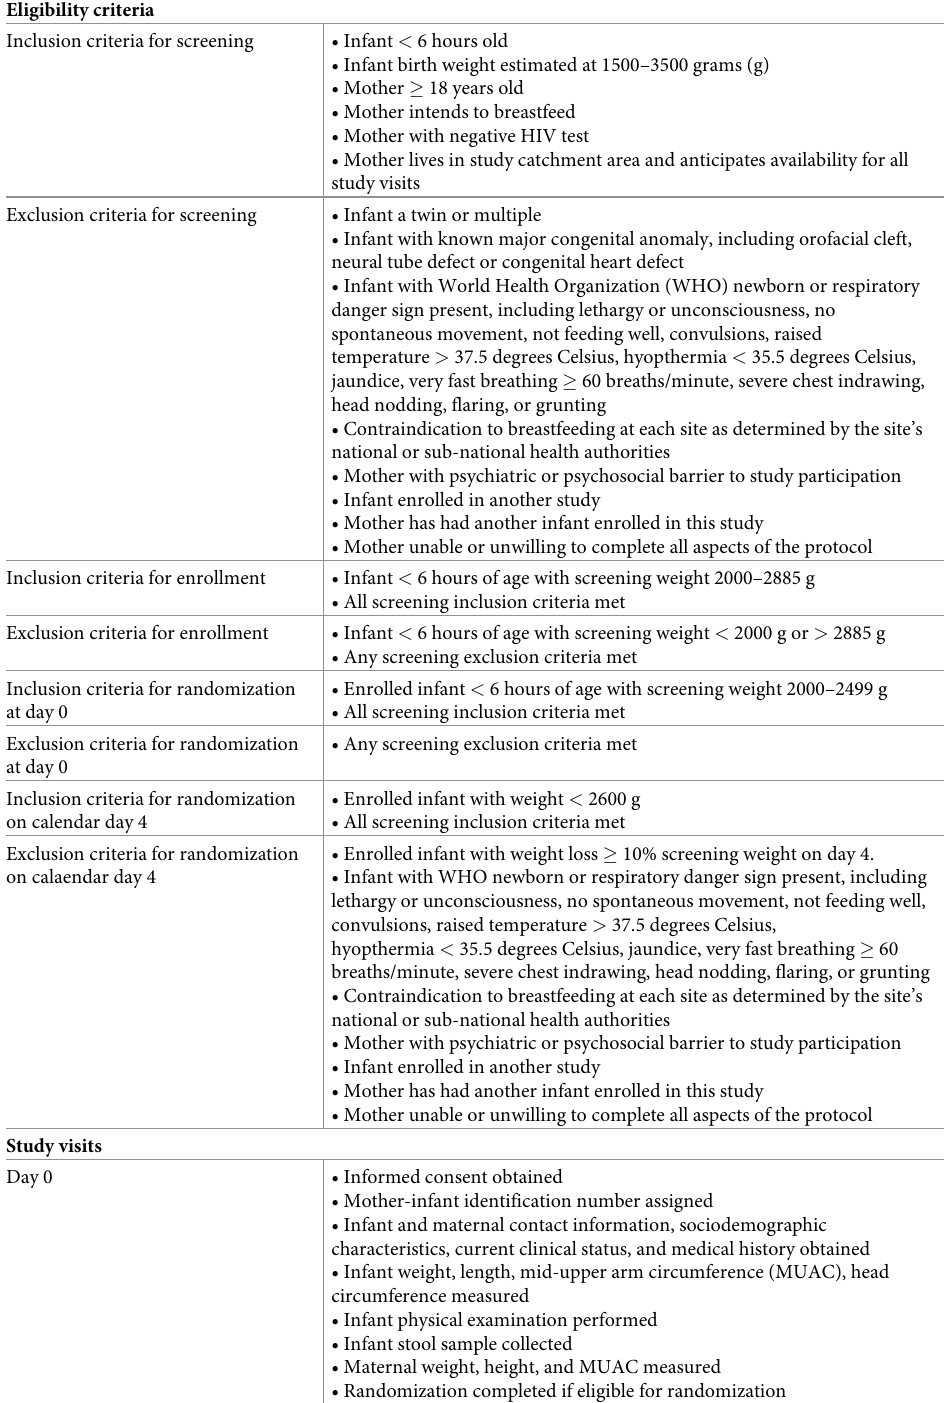
Table 1. Study eligibility criteria, visits, measurements, and